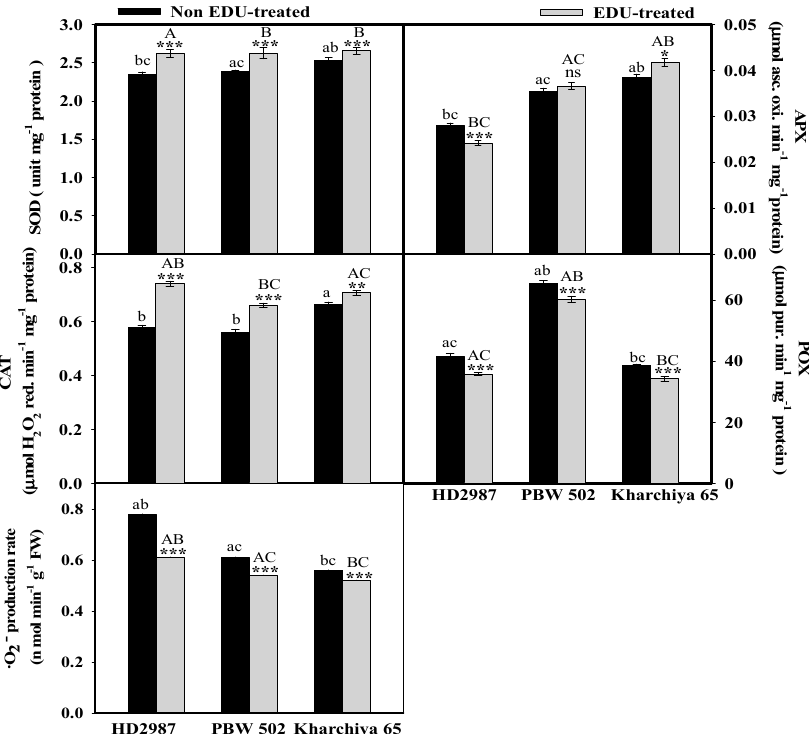
Figure 2. Effect of EDU on antioxidative enzymes such as superoxide dismutase (SOD), ascorbate peroxidase (APX), catalase (CAT), peroxidase (POX) and the superoxide radical production rate (SOR) in wheat cultivars. Values are mean ± SE; n = 9. Symbols above the bars represent significant variability between EDU- and non-EDU-treated plants. The one, two and three asterisks indicate the significance levels at * p ≤ 0.05, ** p ≤ 0.01, and *** p ≤ 0.001, and ns is non-significant. Significant variations between cultivars under EDU and non-EDU treatment are respectively represented by different capital and small letters ( p <